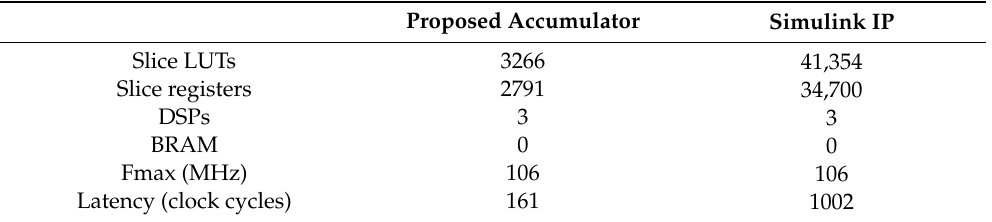
Table 5. Post implementation kernel resource usage and maximum frequency on Xilinx Artix 7 FPGA.